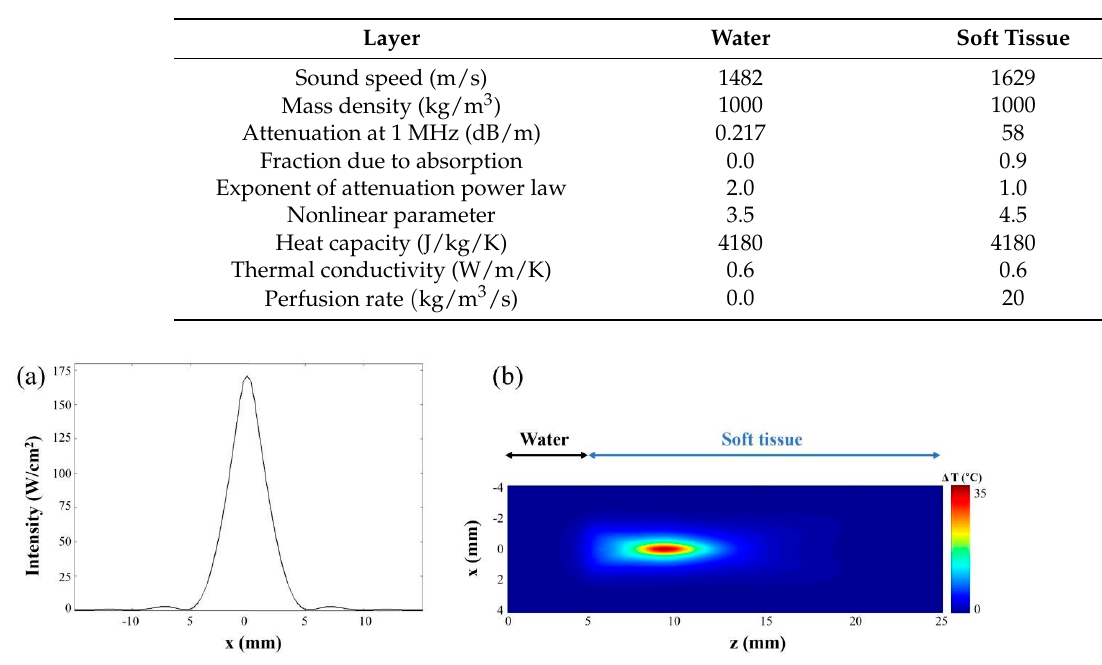
Figure 3. Acoustic pressure field of the BTB transducers measured with a needle hydrophone. ( a , c ) are one-dimensional lateral distributions for 5.3 MHz and 20.0 MHz transducers, respectively. The − 6 dB lateral beam width was measured to be 600 μ m and 200 μ m, respectively; ( b ) depth of focus (DOF) of a 5.3 MHz transducer was measured and found to be 1.4 mm. Ultrasonic input parameters: Vpp = 20 V, cycle numbers of 3, and pulse repetition frequency of 1 kHz; ( d ) represents acoustic intensities at focus according to input voltages using a 5.3 MHz transducer. Table 1. Parameters used in the simulation.